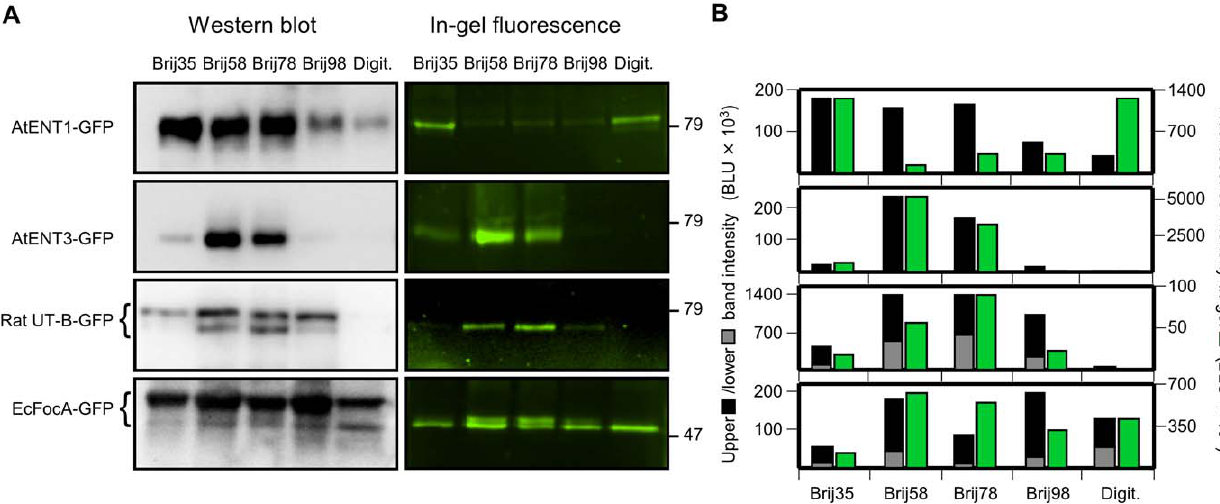
Figure 3. Semi-quantification of protein yield and in-gel GFP fluorescence of representative membrane protein-GFP fusions. A . Shown are Western blot (left panel) and in-gel fluorescence signals (right panel) of GFP fusions with Arabidopsis nucleoside transporters, AtENT1 and AtENT3, the rat urea transporter B, UT-B, and the E. coli formate transporter, EcFocA, after cell-free synthesis in the presence of various detergents of the Brij-type and digitonin (Digit.). For membrane protein characteristics see text. The molecular weight of marker proteins is indicated on the right. B . The black and gray bars represent intensities of the upper and lower band from the Western blot and the green bars those of the in-gel GFP fluorescence. The intensity units are arbitrary (BLU – biomedical light units). The differences in scale of the ordinates derive from different exposure times used in the individual experiments.